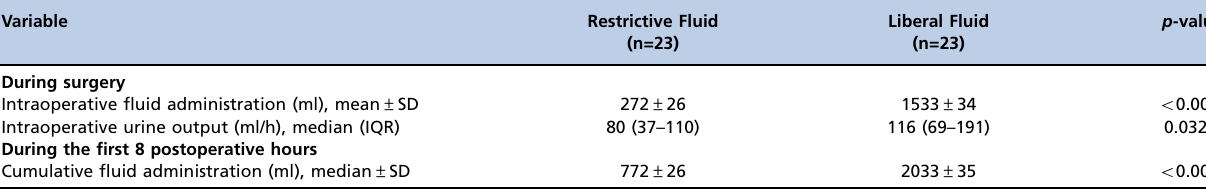
Table 2 - Intraoperative and postoperative fluid